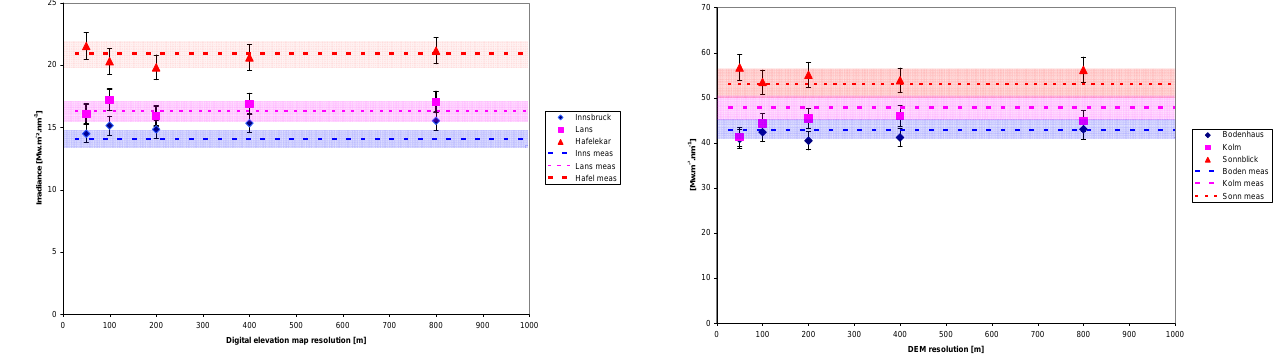
Figure 11: Modeled 3-D UV irradiance calculations (305 nm) for 24 th February, 12:30 UTC Fig. 11. Modeled 3-D UV irradiance calculations (305nm) for 24 as a function of DEM resolution. Dotted lines show the measurements which correspond to February, 12:30UTC as a function of DEM resolution. Dotted lines the locations and the time of calculation. Solar zenith angle is 56.91 degree. The shapes show show the measurements which correspond to the locations and the the model results (diamond = Innsbruck, square = Lans, triangle = Hafelekar) The error bars time of calculation. Solar zenith angle is 56.91 degree. The shapes show the accuracy of the model simulations (±5%). The coloured areas around the lines of show the model results (diamond=Innsbruck, square=Lans, trian- measurements indicate the measurement uncertainty (=±5%). gle=Hafelekar) The error bars show the accuracy of the model sim- ulations ( ± 5%). The coloured areas around the lines of measure- ments indicate the measurement uncertainty (= ± 5%).